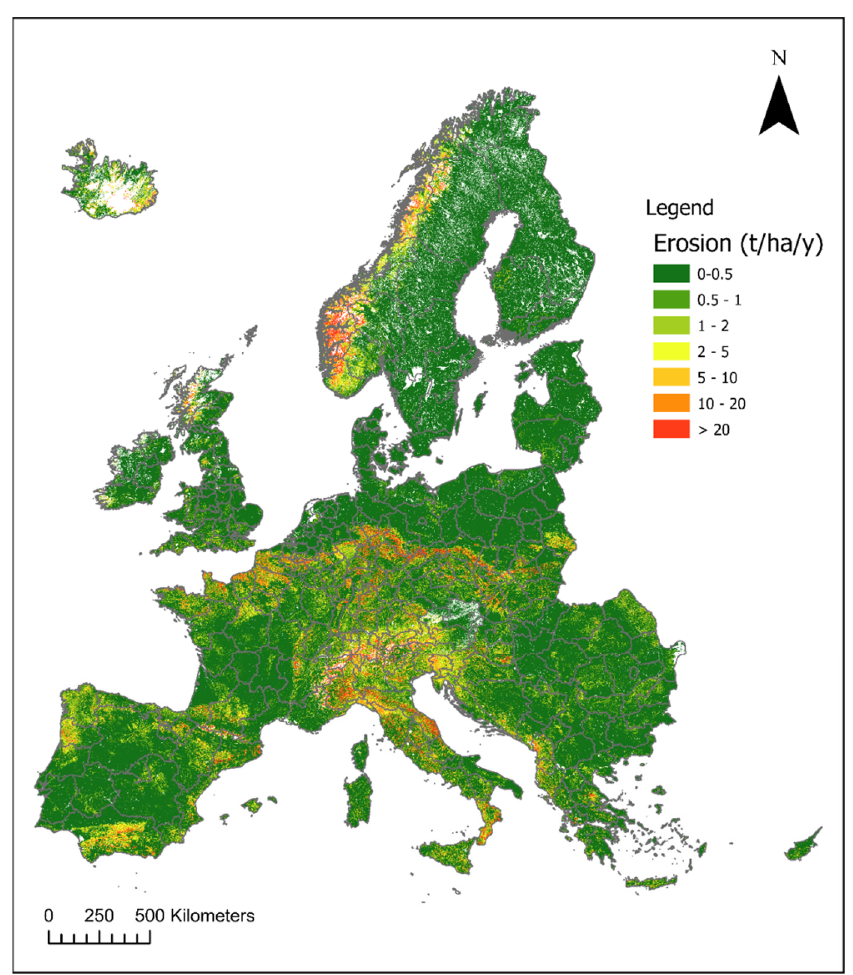
Figure 6. Simulated long-term average erosion rates across Europe using the PESERA model. SoilCare partners’ feedback on PESERA simulated erosion maps included for Spain that it seemed relatively low, compared to the national soil erosion map [84]. However, areas in the south show relatively high erosion in both maps. Belgium partners indicated that the relatively high erosion values for row crops like potato and sugar beet seemed valid, but that simulated erosion values for maize and vegetables, which have a wide spacing, were too low compared to their experience, especially when compared to simulated higher erosion in cereals. For Poland and Germany, simulated patterns of erosion were found to be plausible and matching e.g., the German national erosion map [85] with higher erosion in central Germany and very low to no erosion in the northern half of the country.